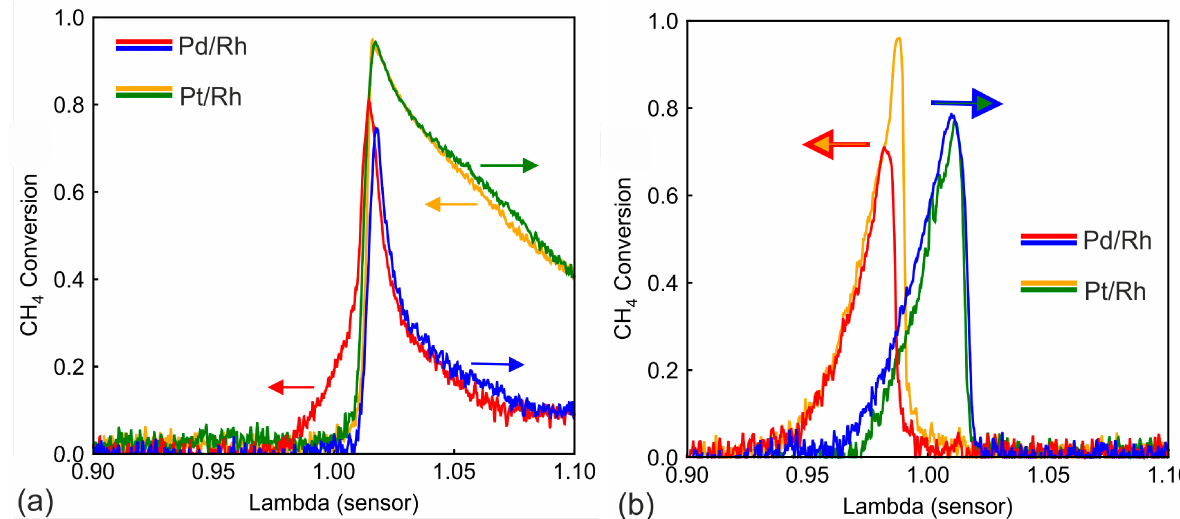
Figure 6. CH 4 conversion during λ ramp-up and λ ramp-down in the Pd/Rh and Pt/Rh catalyst, at temperature ( a ) 630 °C ( b ) 360 °C. temperature ( a ) 630 ◦ C ( b ) 360 ◦